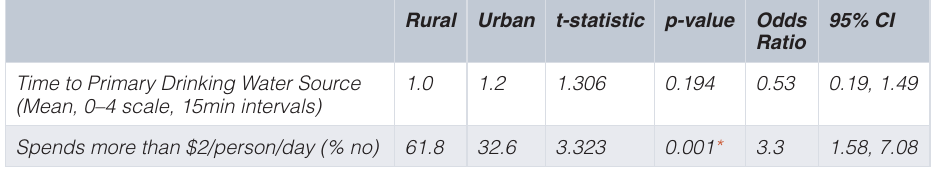
Table 3. Geographical univariate analysis. Romania, 2016. Reference population for all variables is urban. * indicates significance at 95% CI level.